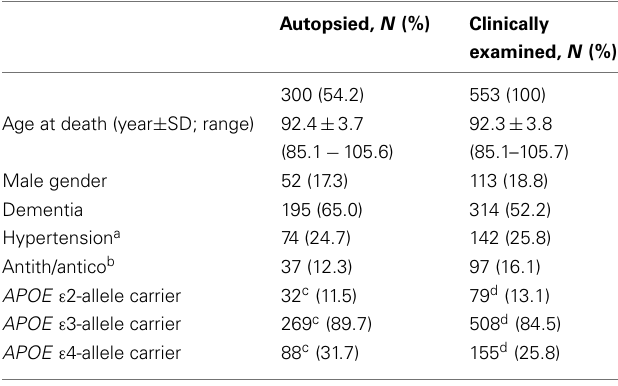
Table 1 | Demographic features of the autopsied subpopulation compared with the wholeVantaa 85 + study